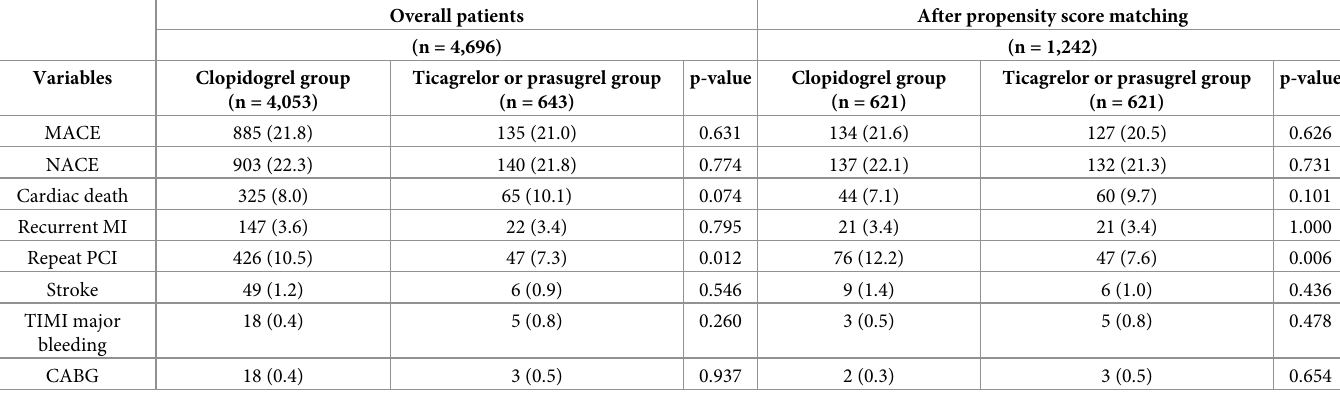
Table 4. Clinical outcomes in the clopidogrel and ticagrelor or prasugrel groups during a 3-year follow-up period. Overall patients